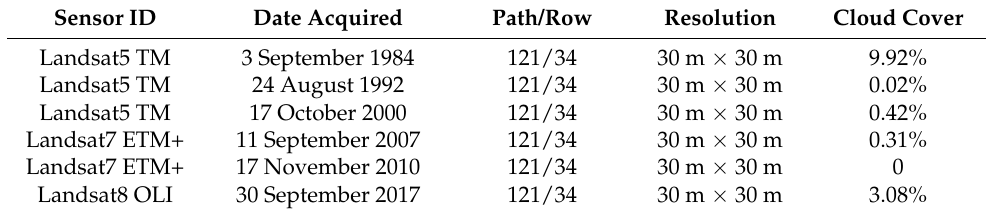
Table 1. The detailed information of the six Landsat satellite images. Sensor ID Date Acquired Path/Row Resolution Cloud